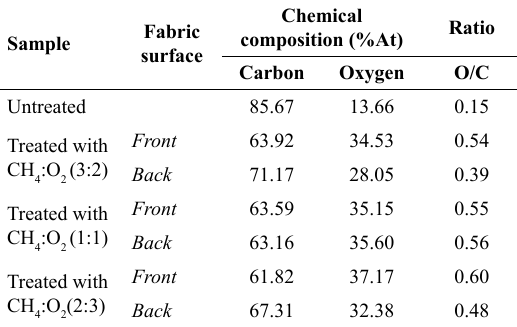
Table 1. Chemical composition and O/C ratio by XPS to each surface of untreated and treated samples.